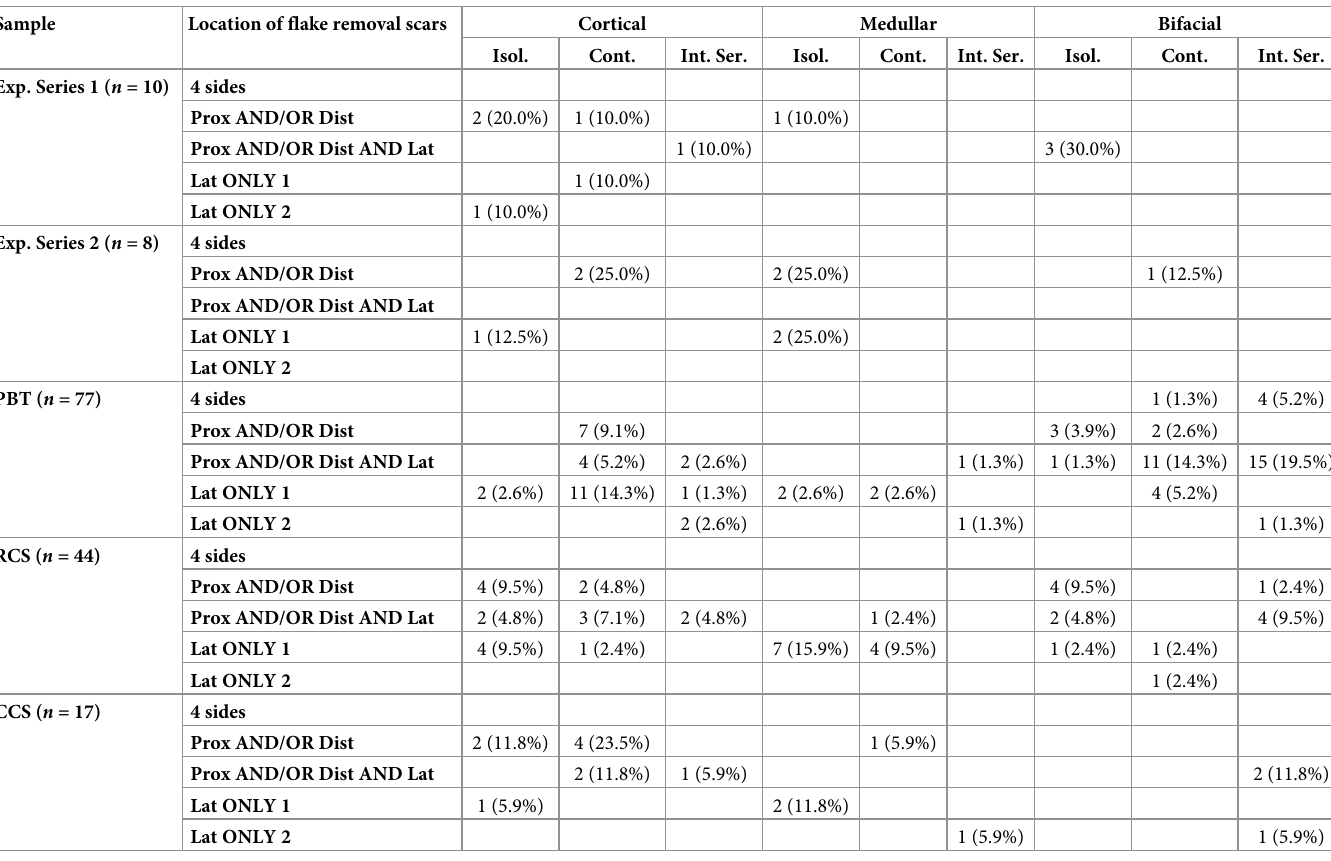
Table 3. Relative proportion for the location and arrangement of flake scars by sample considered in the present study. Sample Location of flake removal